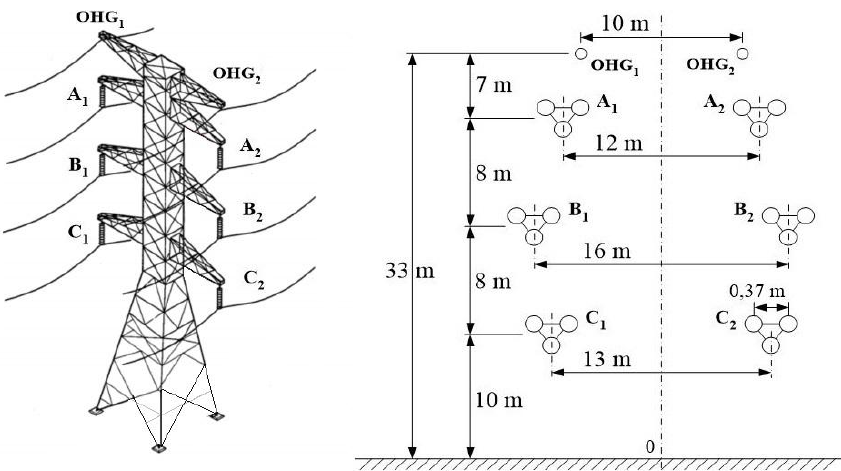
Figure 1. High-voltage double-circuit: three-bundled transmission